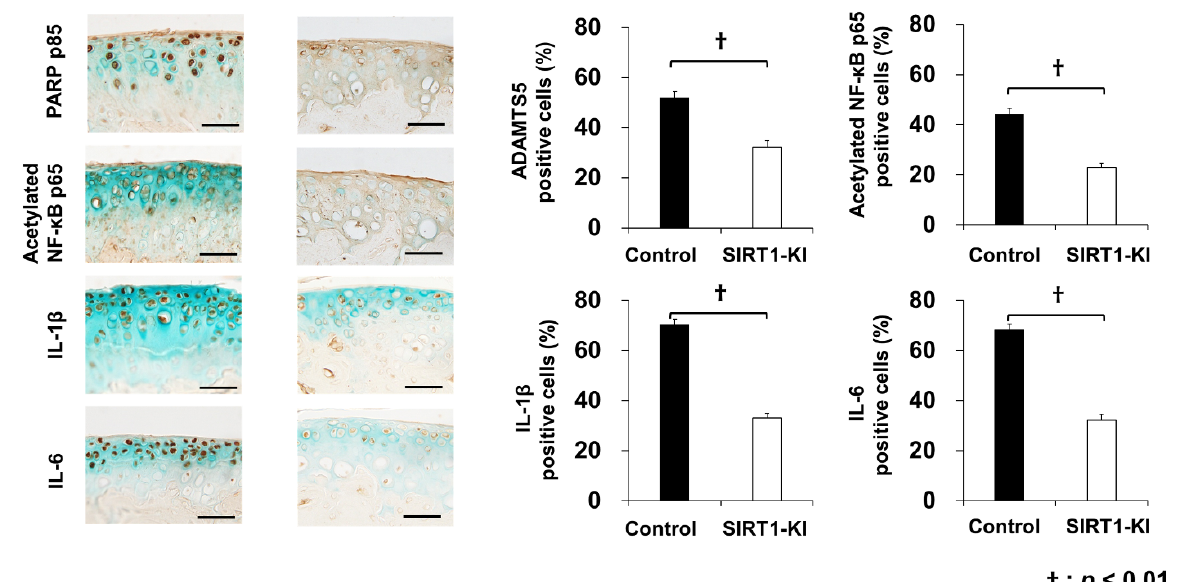
Figure 4. ( A ) Immunohistochemistry of type-II collagen, MMP-13, ADAMTS-5, cleaved caspase 3, PARP p85, acetylated NF- κ B P65, IL-1 β , and IL-6 in the medial tibial plateau at 8 weeks postsurgery. Scale bars = 50 µ m. ( B ) The percentage of type-II collagen-, MMP-13-, ADAMTS-5-, cleaved caspase 3-, PARP p85 fragment-, acetylated NF- κ B P65-, IL-1 β -, and IL-6-positive cells. Three micrographs of the medial tibial plateau were taken at × 40 magnification. The percentage was determined as the positive cells/total number of cells at × 100 magnification ( n = 5 mice/group for each time point; † p < 0.01).